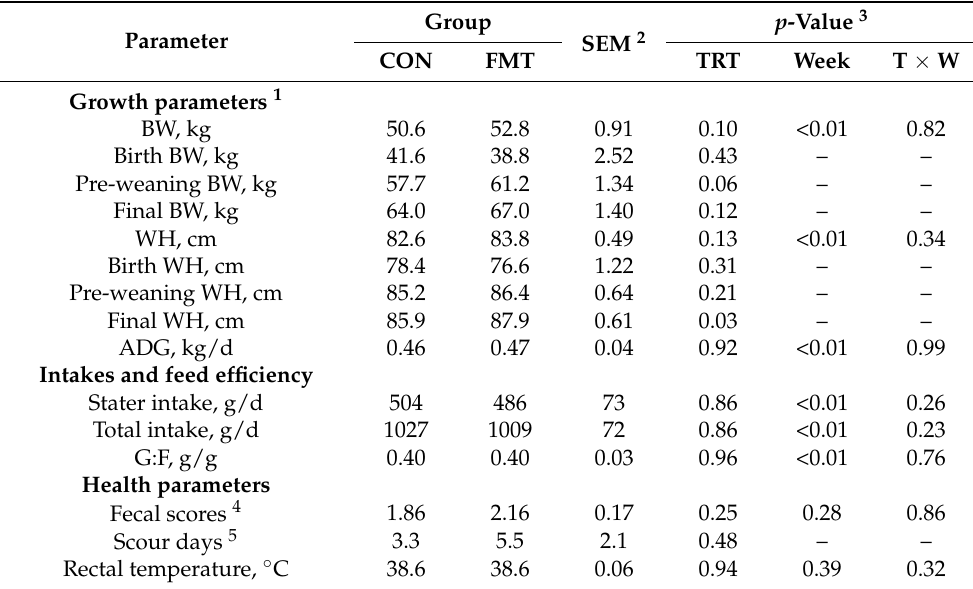
Table 1. Growth, intakes, feed efficiency, and health parameters in Holstein dairy calves raised under a conventional nutritional program (CON) or subjected to fecal microbiota transplantation (FMT).